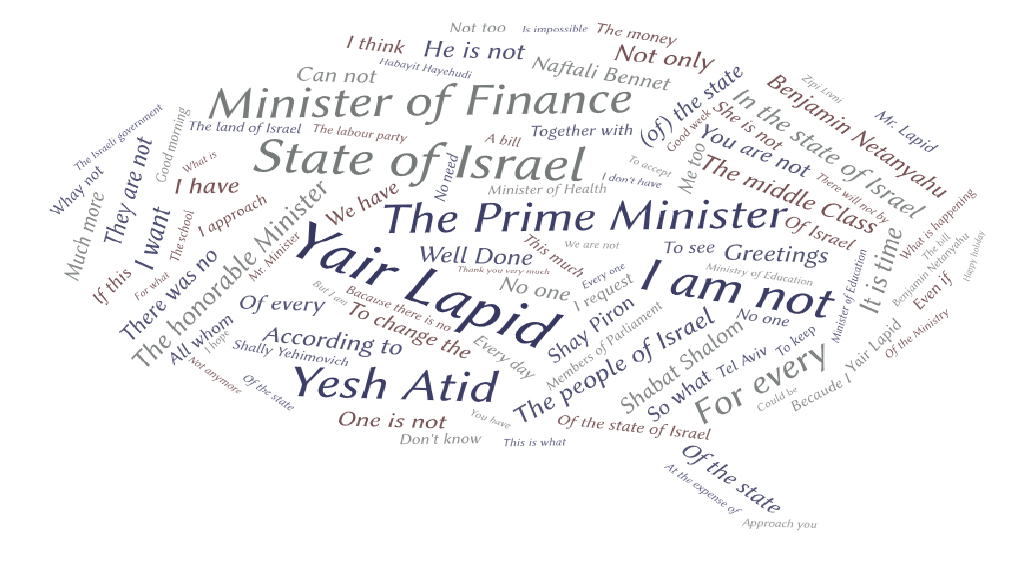
Figure 2: Word cloud of 100 most frequent terms in the ordinary corpus. Size represents scale